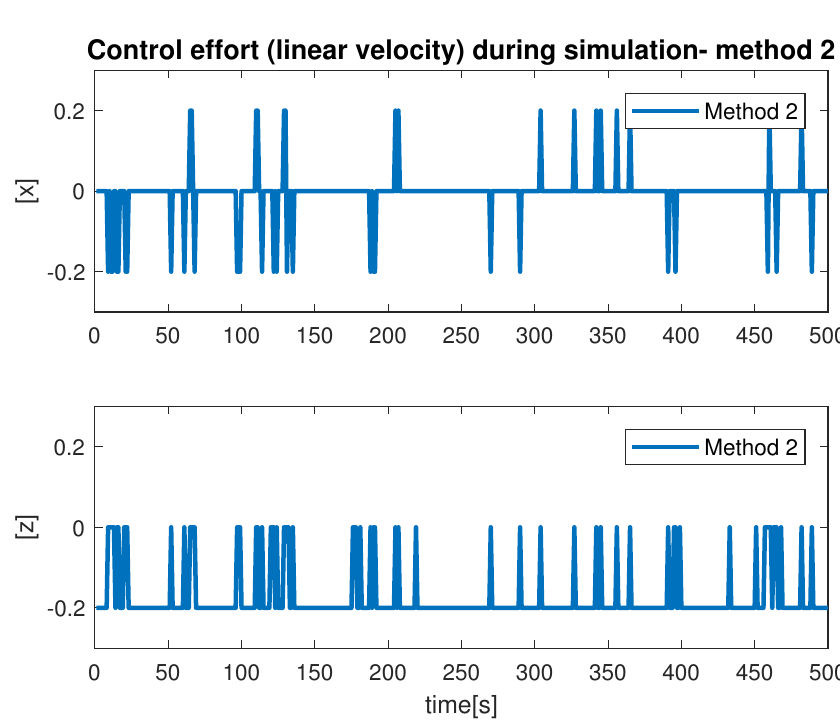
Figure 15. Velocity profile by Method